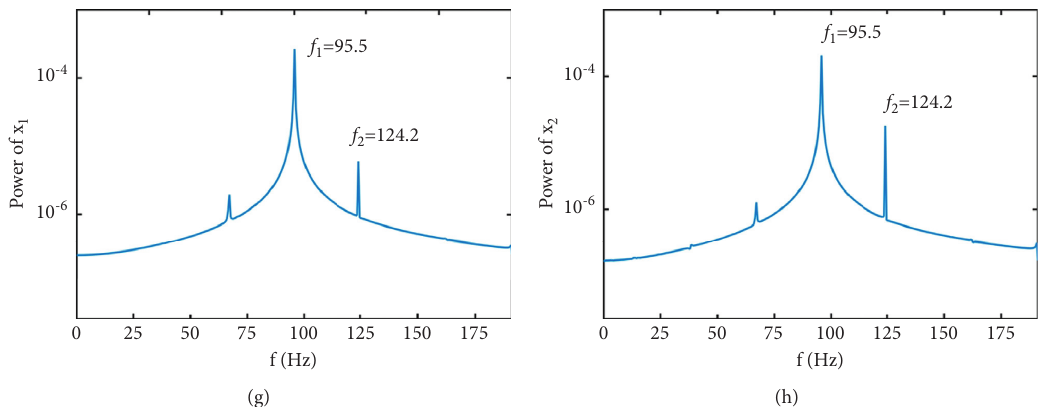
Figure 6: Spectrum of the responses of the low- and high-pressure rotors in the horizontal direction at different frequency points.